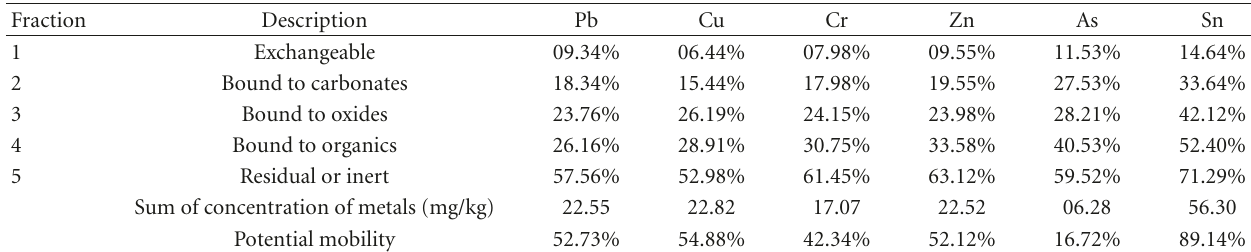
Table 6: Analysis of heavy metals